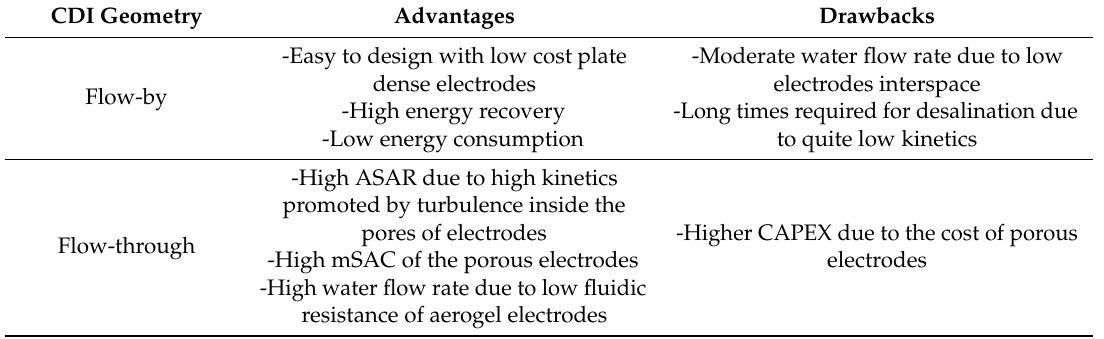
Table 4. Mains advantages and drawbacks of flow-by and flow-through CDI cells for